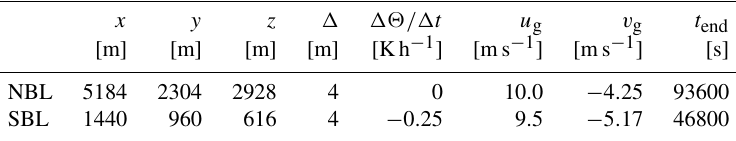
Table 3. Set-up of the precursor simulations: size of the model domain in the streamwise x , spanwise y and vertical z direction; grid size (cid:49) ; cooling rate (cid:49)(cid:50)/(cid:49)t ; geostrophic wind speed components at the surface in the x and y direction u g and v g ; and total simulated time t end . x y z